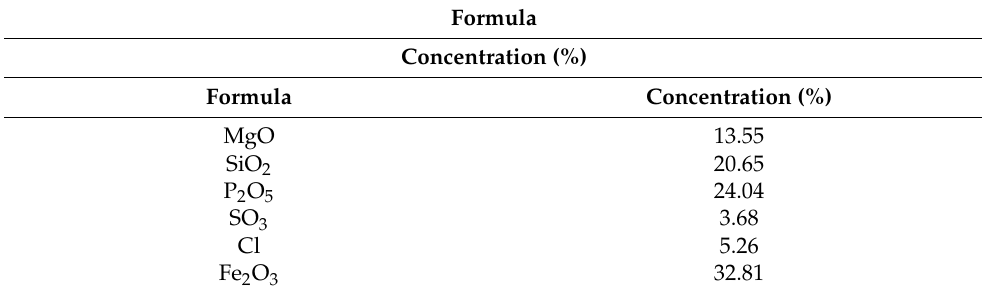
Figure 8. Energy Dispersive X-ray Fluorescence (EDXRF) spectrum of the FeNP/NFC composite. Table 1. Composition of oxide groups in iron nanoparticles and cellulose nanofibers (FeNPs/NFCs).